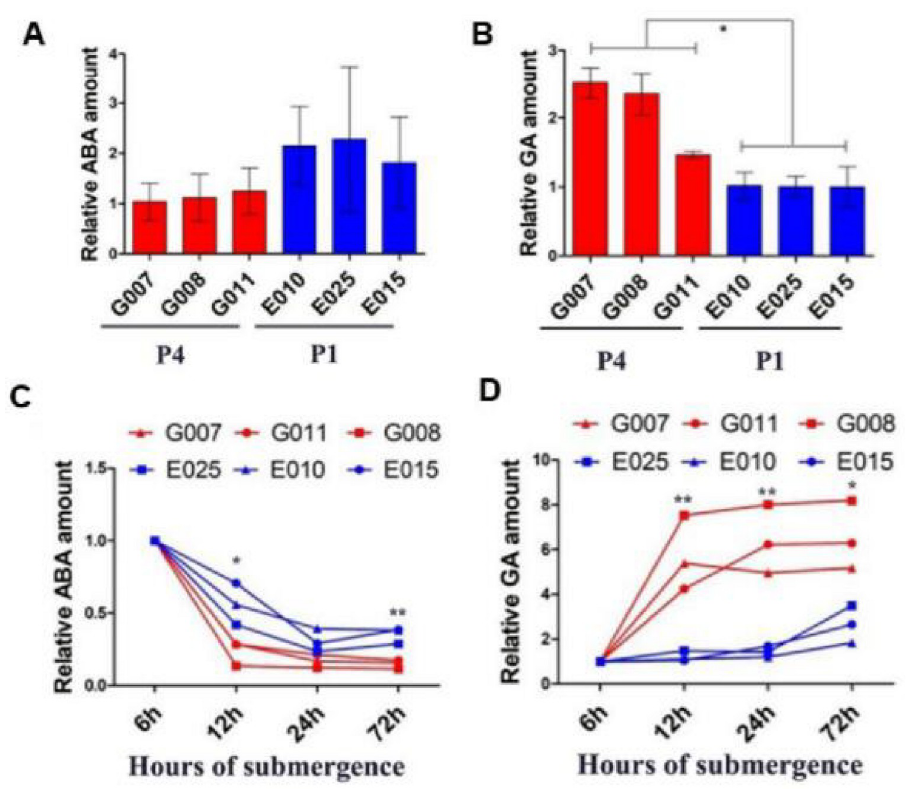
Fig 3. Quantification of endogenous GA 3 and ABA in F . hodginsii and changes in response to flooding stress treatments in provenance 1 (P1) and provenance 4 (P4). ( A&C ) Three varieties of P1 (E010, E025, E015) and P4 (G007, G008, G011) showing the amount of endogenous ABA indicating the change trend after 12 h/24 h/72 h flooding stress treatments compared with 6 h. ( B&D ) The amount of endogenous GA 3 in E010, E025, E015, and G007, G008, G011, and the change in GA 3 in the seedings subjected to 12 h/24 h/72 h flooding stress treatments compared with 6 h. The data are shown as means ± SD (n = 3). � and �� indicate significant differences ( P < 0.05 and P < 0.01, respectively) between P1 and P2 in different times, based on one-way ANOVA with multiple comparisons using Tukey-test.